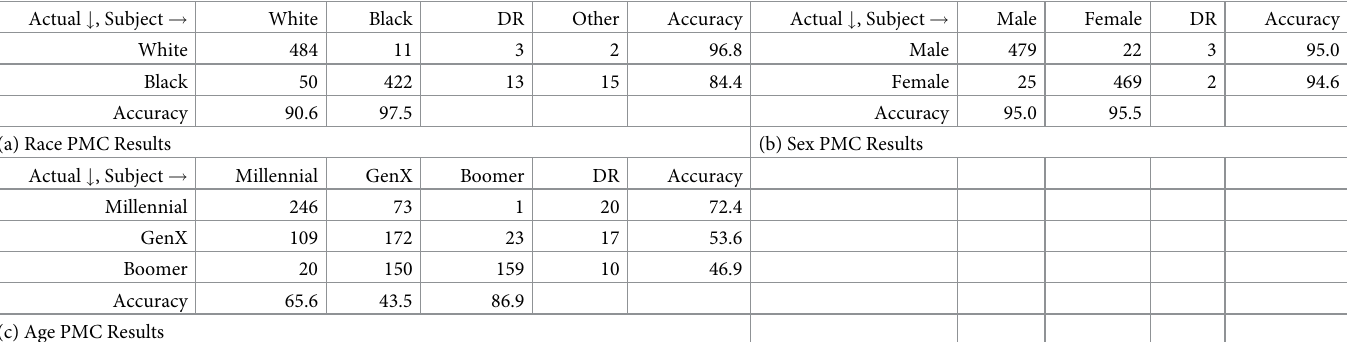
Table 5. Results of the post manipulation check (PMC) on the final 1,000 subjects in our experiment as confusion matrices. Rows indicate the true treatment manipu- lations and columns indicate the subjects’ responses. Accuracy tabulated in the last columns is the recall rate (in percent) and accuracy tabulated in the last row is the preci- sion rate (in percent). DR indicates that the subject responded “I don’t